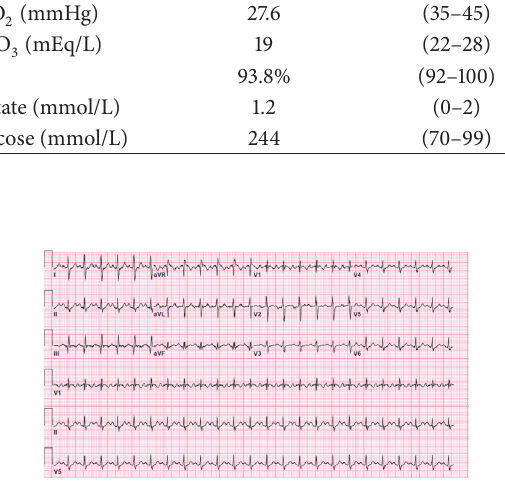
Figure 1: Electrocardiogram showing sinus tachycardia and right ventricular strain pattern S 1 Q 3 T 3 (deep S wave in lead I, Q wave in lead III, and inverted T wave in lead III).